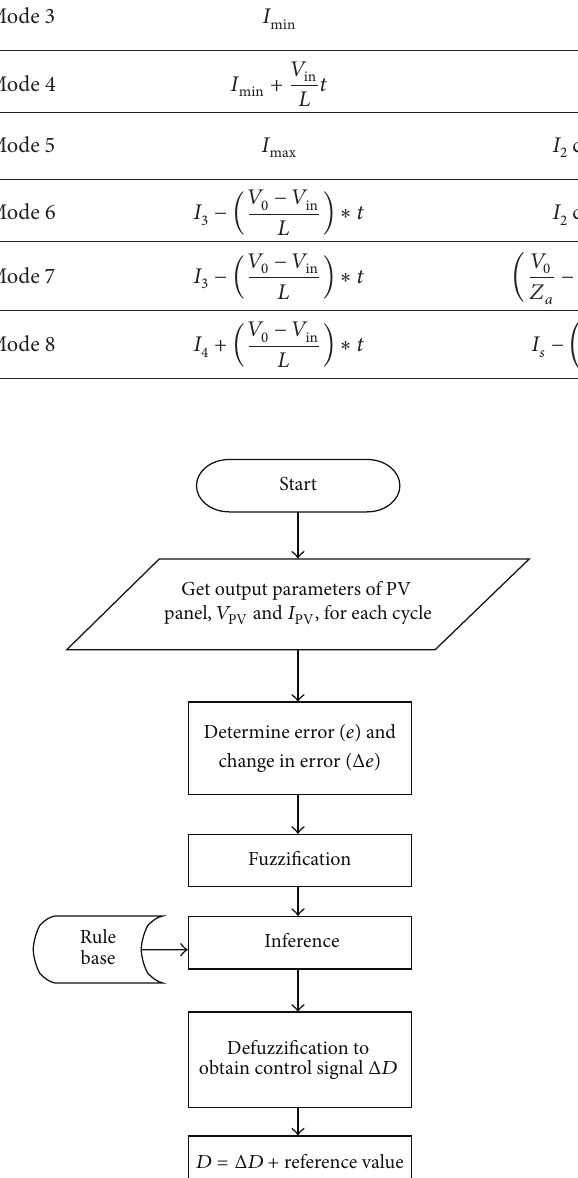
Figure 3: Flowchart of fuzzy logic based power tracker.